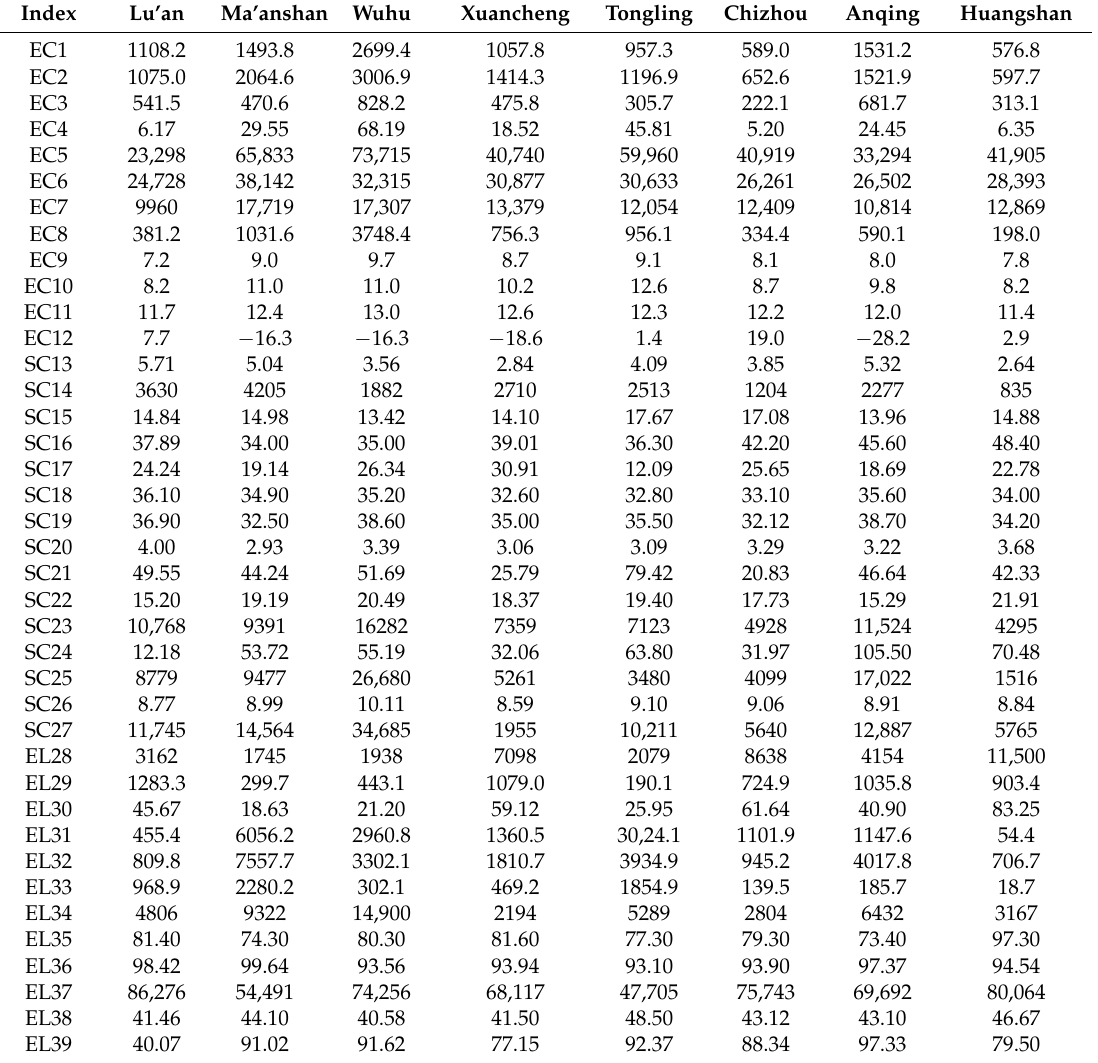
Table 3. Evaluation index data of eight cities of Anhui province in the south of Huaihe